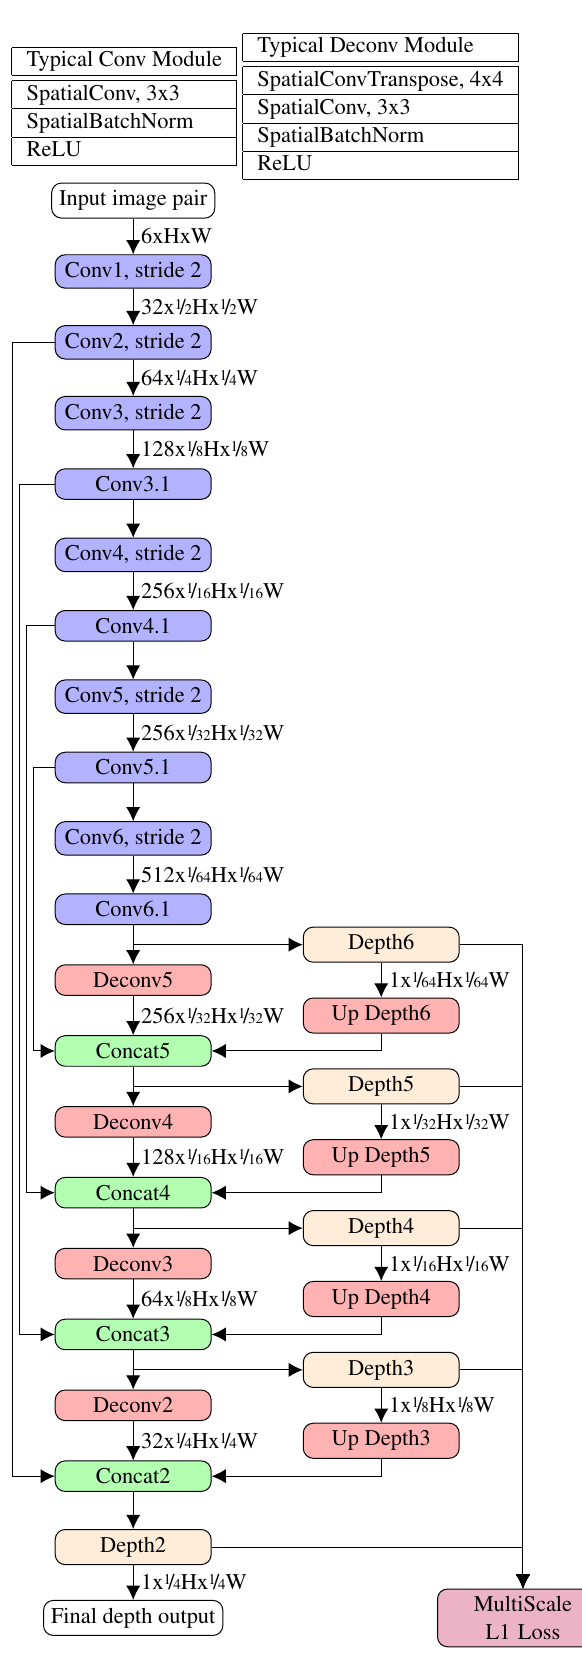
Figure 3. DepthNet structure parameters, Conv and Deconv modules detailed above